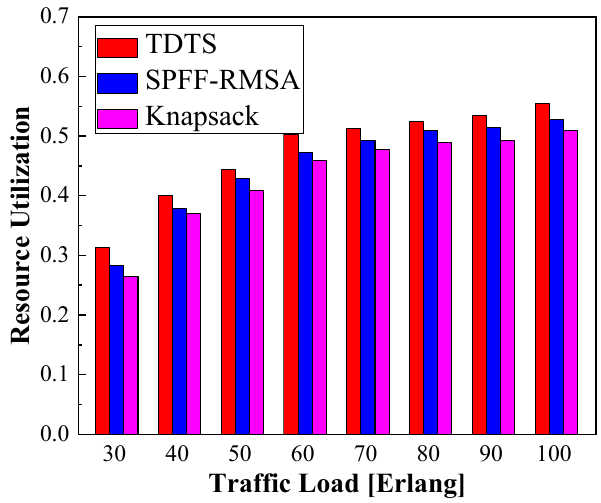
Figure 12. Resource utilization of TDTS, SPFF-RMSA, and Knapsack.